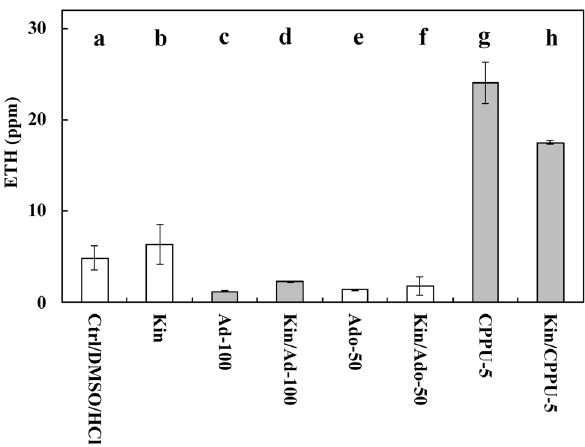
Figure 4. Ethylene (ETH) amounts in the atmosphere of growing Vicia faba ssp. minor of untreated (Ctrl) seedlings and those treated with Ad (adenine; 100 μM, series Ad–100), Ado (5 ′ -amine-5 ′ -deoxyadenosine, 50 μM, series (Ado–50), CPPU (N-(2-chloro-4-piridylo)-N ′ -phenylurea, 5 μM, series CPPU–5) kinetin (Kin) with 100 μM Ad (series Kin/Ad–100), or Kin with 50 μM Ado (series Kin/Ado), Kin with 5 μM CPPU (series Kin/CPPU–5). Bars indicate ± SE of the results from three biological replicates. The means of the results with the same letter above the column are not significantly different at p ≤